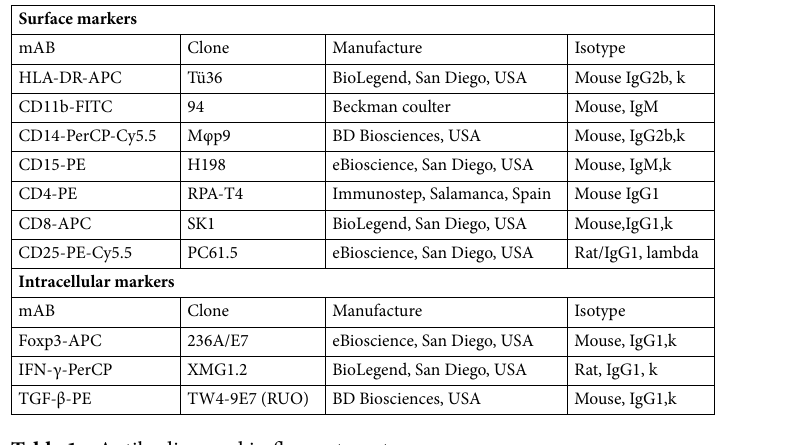
Table 1. For cell surface staining, cells were suspended in a tube containing FACS buffer (PBS 1x, Sodium azide 0.01% and BSA 1%) and surface staining was measured following incubation with the antibody for 30 min at